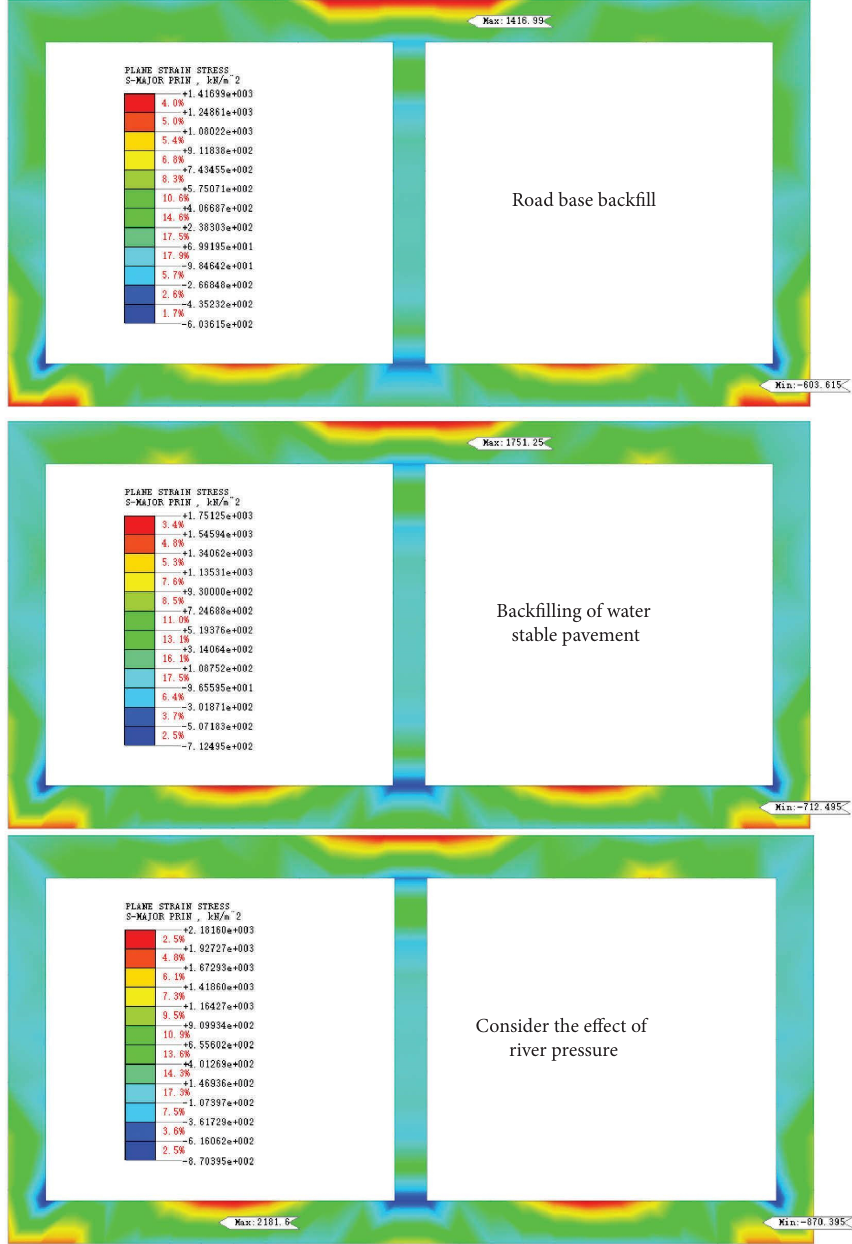
Figure 26: Stress variation of the utility tunnel in the backflling of the roadbed and water-stable